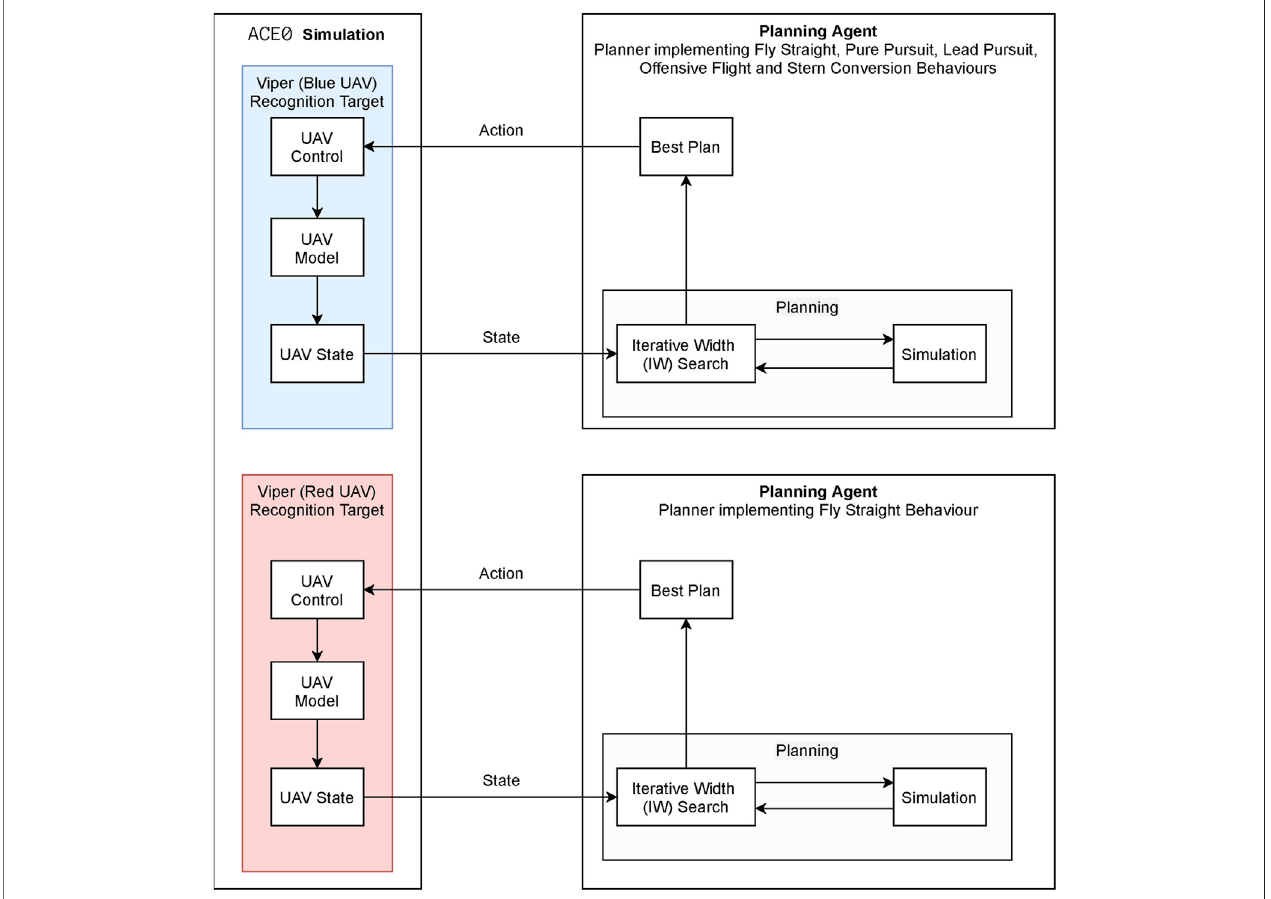
FIGURE 7 | Behaviour generation framework.